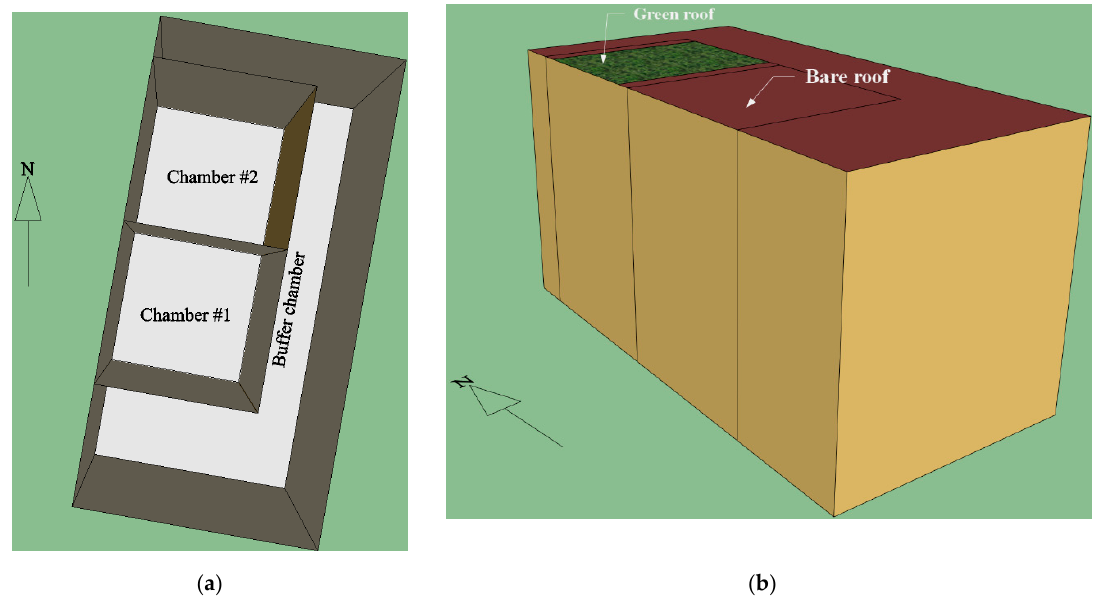
Figure 2. Schematics of the building model for the validation (and measuring points): ( a ) plan drawing; ( b ) axonometric drawing. Table 3. Green roof parameters for the simulation.